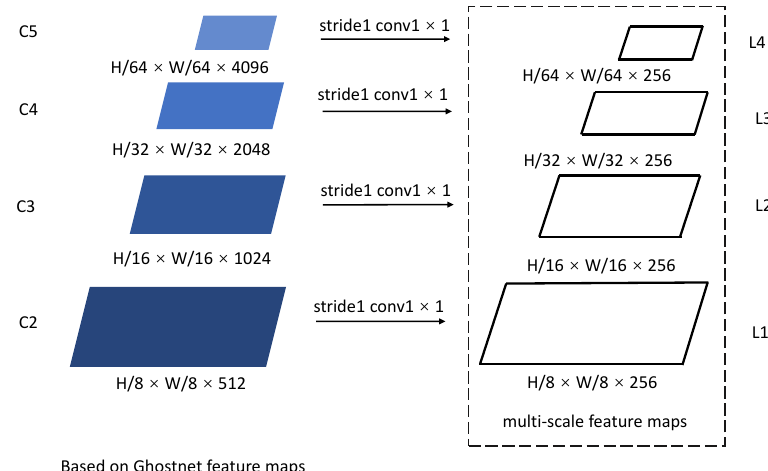
Figure 2. Generation of multiscale feature maps.